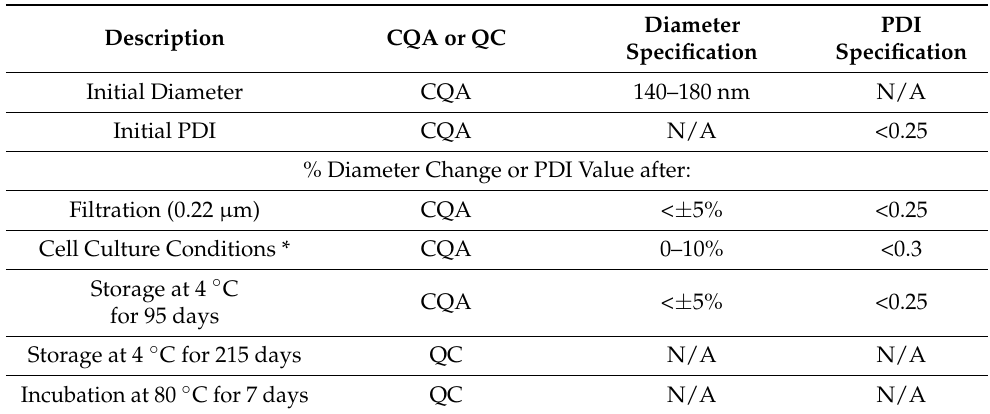
Table 2. Summary of diameter and polydispersity index (PDI) critical quality attribute (CQA) and quality control (QC) testing performed on perfluorocarbon nanoemulsions. * Cell culture conditions: Dilute nanoemulsion 1:80 v / v in full cull culture medium. Incubate for 3 h. Following incubation, centrifuge at 1100 rpm for 5